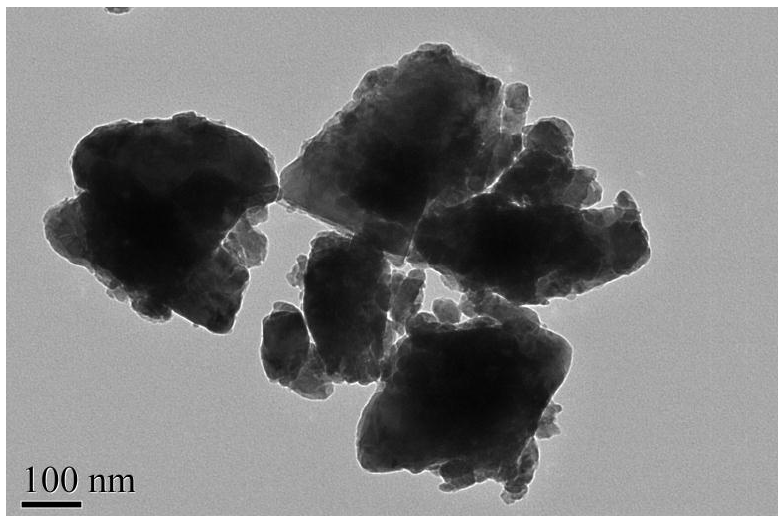
Figure 2. TEM image of ZnBiErO 4 .